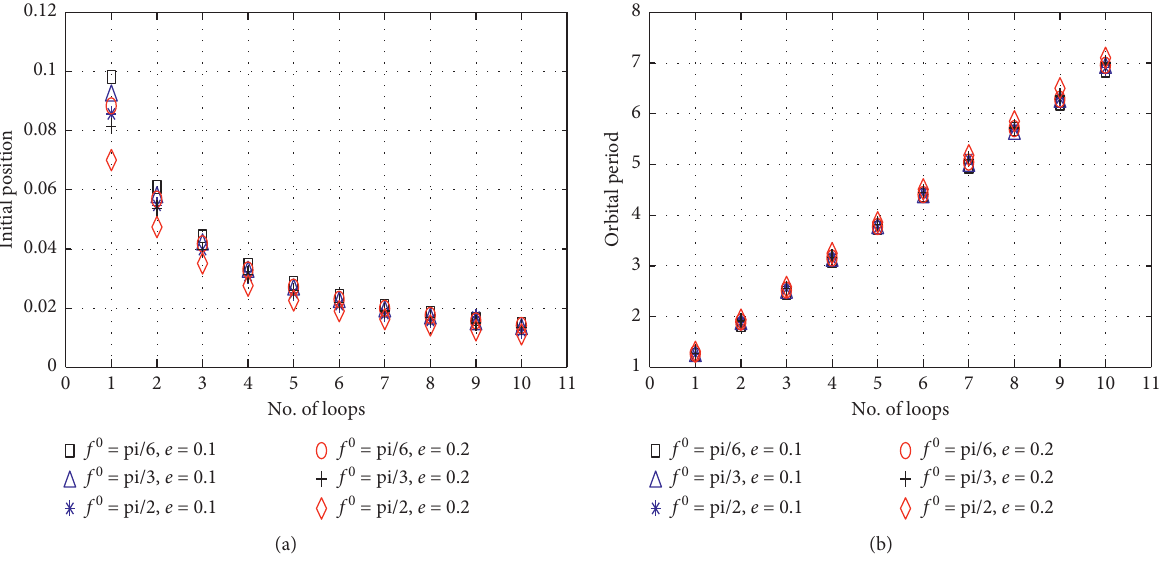
Figure 11: Variation in (a) the initial position of periodic orbits and (b) orbital period when _ y 0 � 0 . 002.